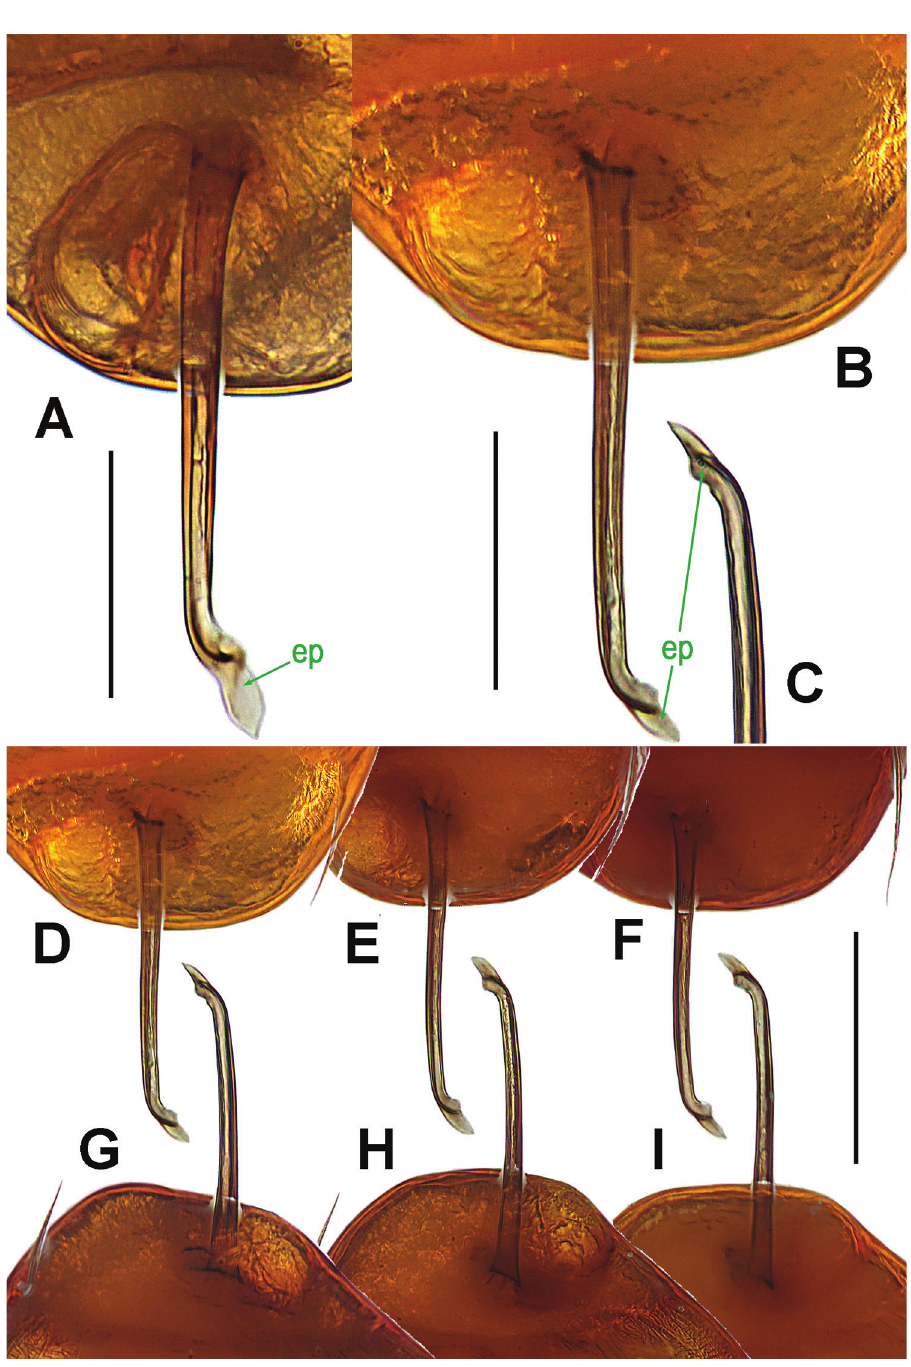
Figure 19. Singaporemma halongense Lehtinen, 1981, male paratype ( A ), and S. lenachanae sp. n., male paratypes ( B–I ). A embolic end, prolateral B–I ditto , prolateral. Abbreviations: ep = embolic part of apes of palpal organ. Scale bars: 0.10